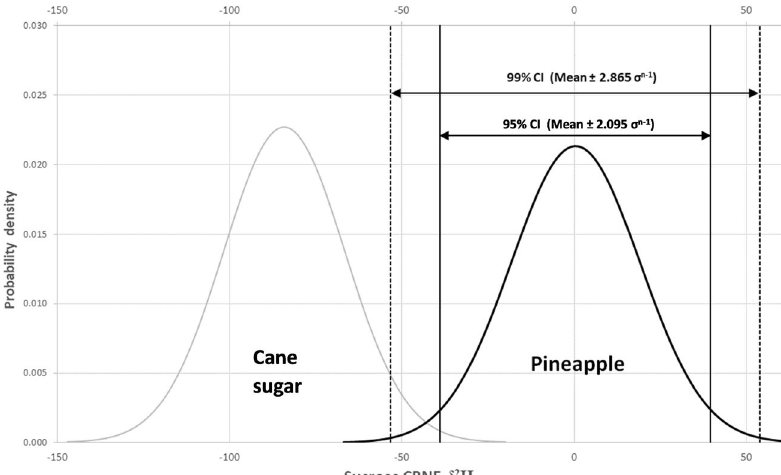
Fig. 2 Gaussian (or normal) distributions created using the NORMDIST function in Microsoft Excel. The distributions are generated from speci fi ed means and standard deviations, for pineapple (black curve) and cane sugar (grey curve) sucrose CBNE δ 2 H values. The solid and dashed vertical lines show the limits between which 95 and 99% of the authentic pineapple juice population would be expected to fall, respectively. These boundaries are based on the mean and standard deviation of the measured dataset and assume that the measured dataset is representative of the entire pineapple juice population and it follows a normal